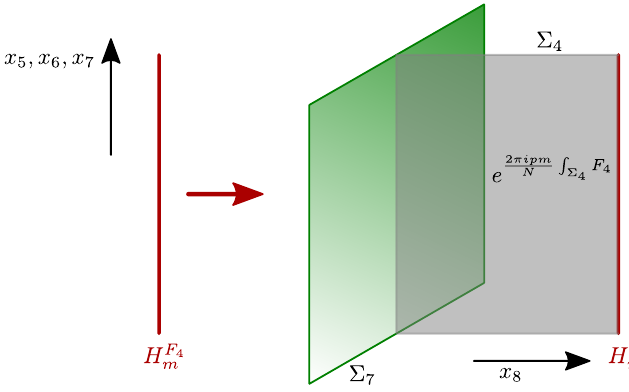
Figure 2 . A magnetic source for F 4 crosses the topological defect and picks up a fractional F 4 flux attached to